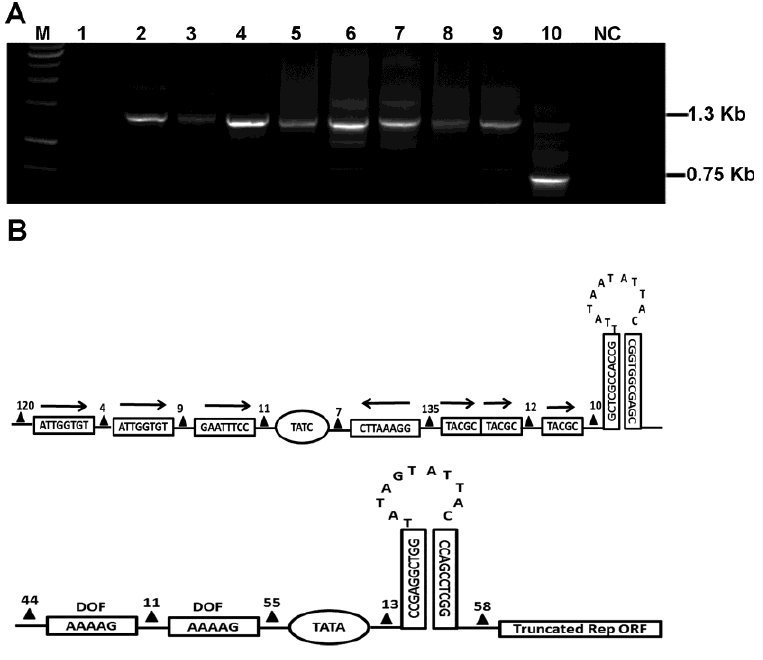
Figure 1. Sequence analysis of RecSat. ( A ) Agarose gel electrophoresis of PCR-amplified products of ten tobacco samples with beta01 and beta02 primers. The DNA products electrophoresed in lane 1–10 were amplified from sample No. YN51-60, respectively. M denotes size marker lane and NC denotes the healthy control lane. ( B ) Schematic representation of the modular organization of the RecSat betasatellite-like SCR (upper panel) and alphasatellite-like replication origin (lower panel). The arrows represent the position and orientation of the putative iterons. Repeated sequence motifs in RecSat are shown in the box. The triangles with a number on the top indicate the number of spacing nucleotides between